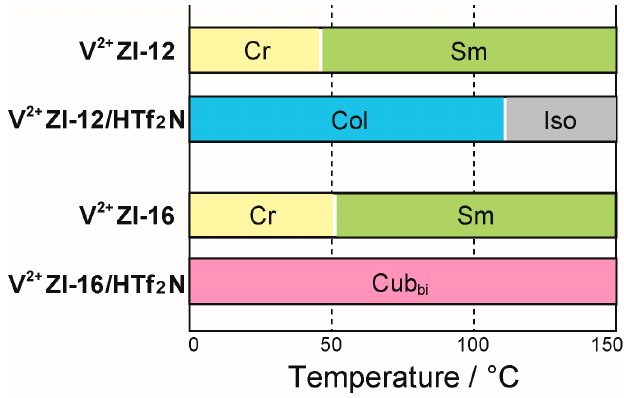
Figure 2. Thermotropic liquid-crystalline behaviors of V 2+ ZI- n and their mixtures with HTf 2 N